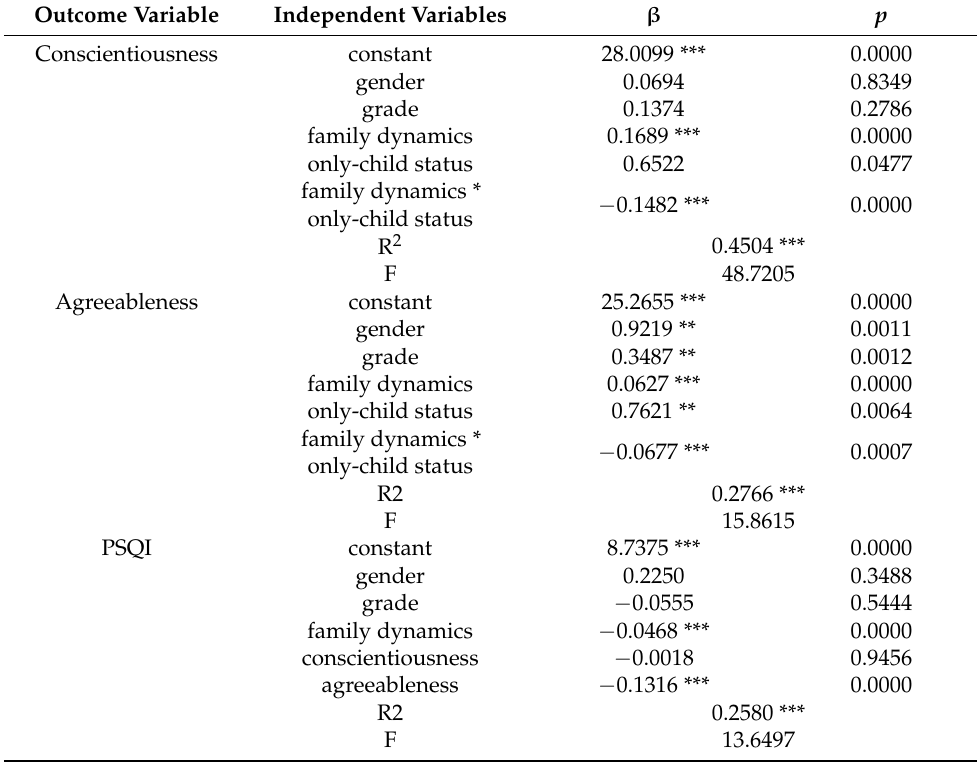
Table 5. The moderated mediation analyses.